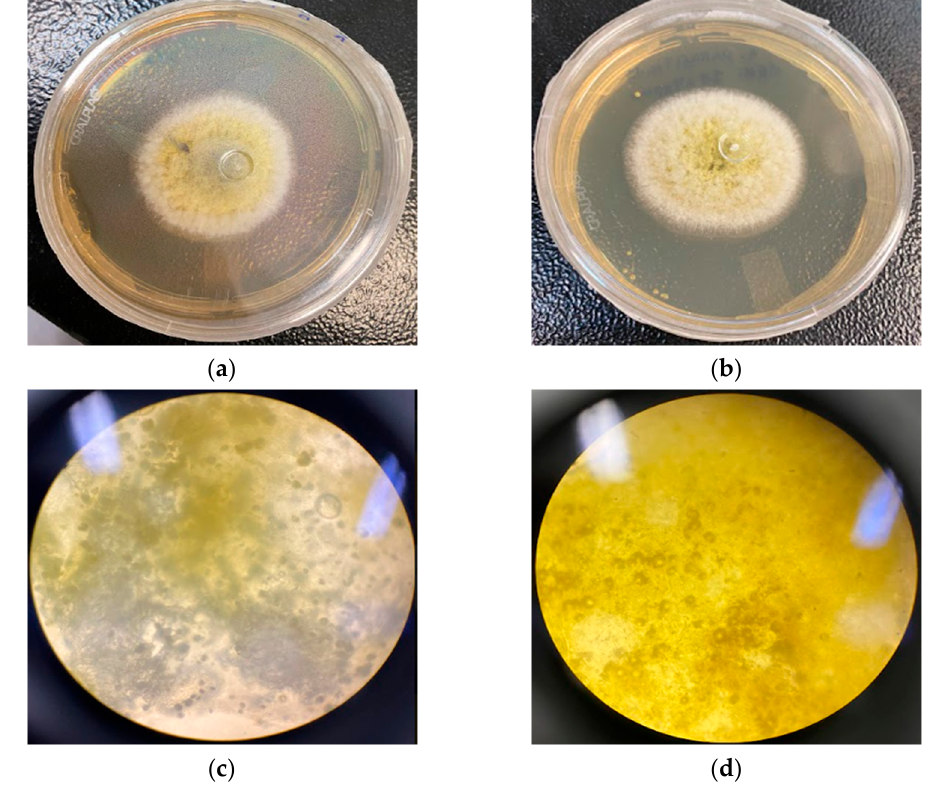
Figure 6. Macroscopic and microscopic comparison between the control colony and the colony with the NE at 2048 µg/mL at 48 h: ( a ) A. parasiticus colony, ( b ) A. parasiticus colony in the presence of the NE at 2048 µg/mL, ( c ) microscopy of A. parasiticus , and ( d ) microscopy of A. parasiticus in the presence of the NE at 2048 µg/mL.